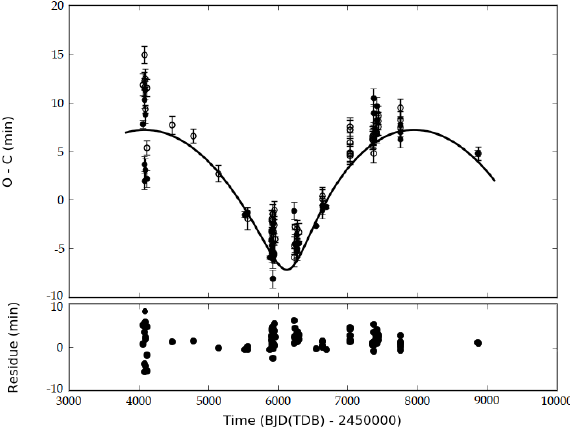
Figure 3. The residue O-C diagram of V1848 Ori showing a sinu- soidal trend on the data and the residual curve (residue between (new values of O-C) calculated from values of fitted parameters to file) with χ 2 r = 11.62, and BIC = 1104.